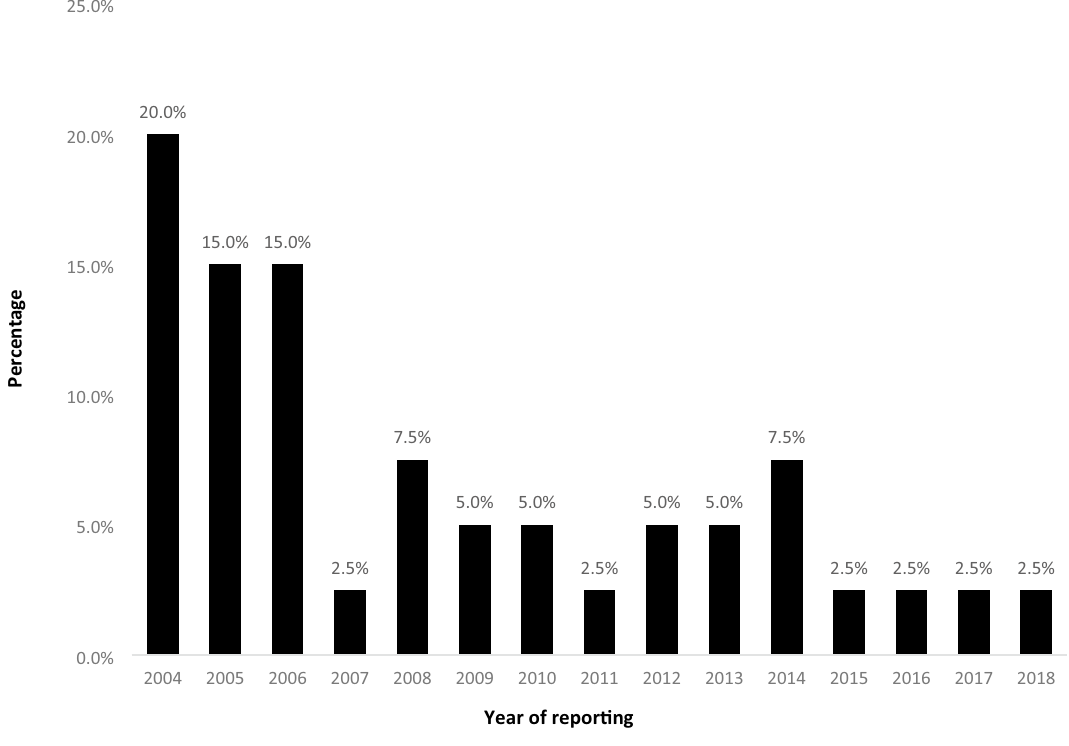
Figure 2. Percentage of labelling errors during medication preparation